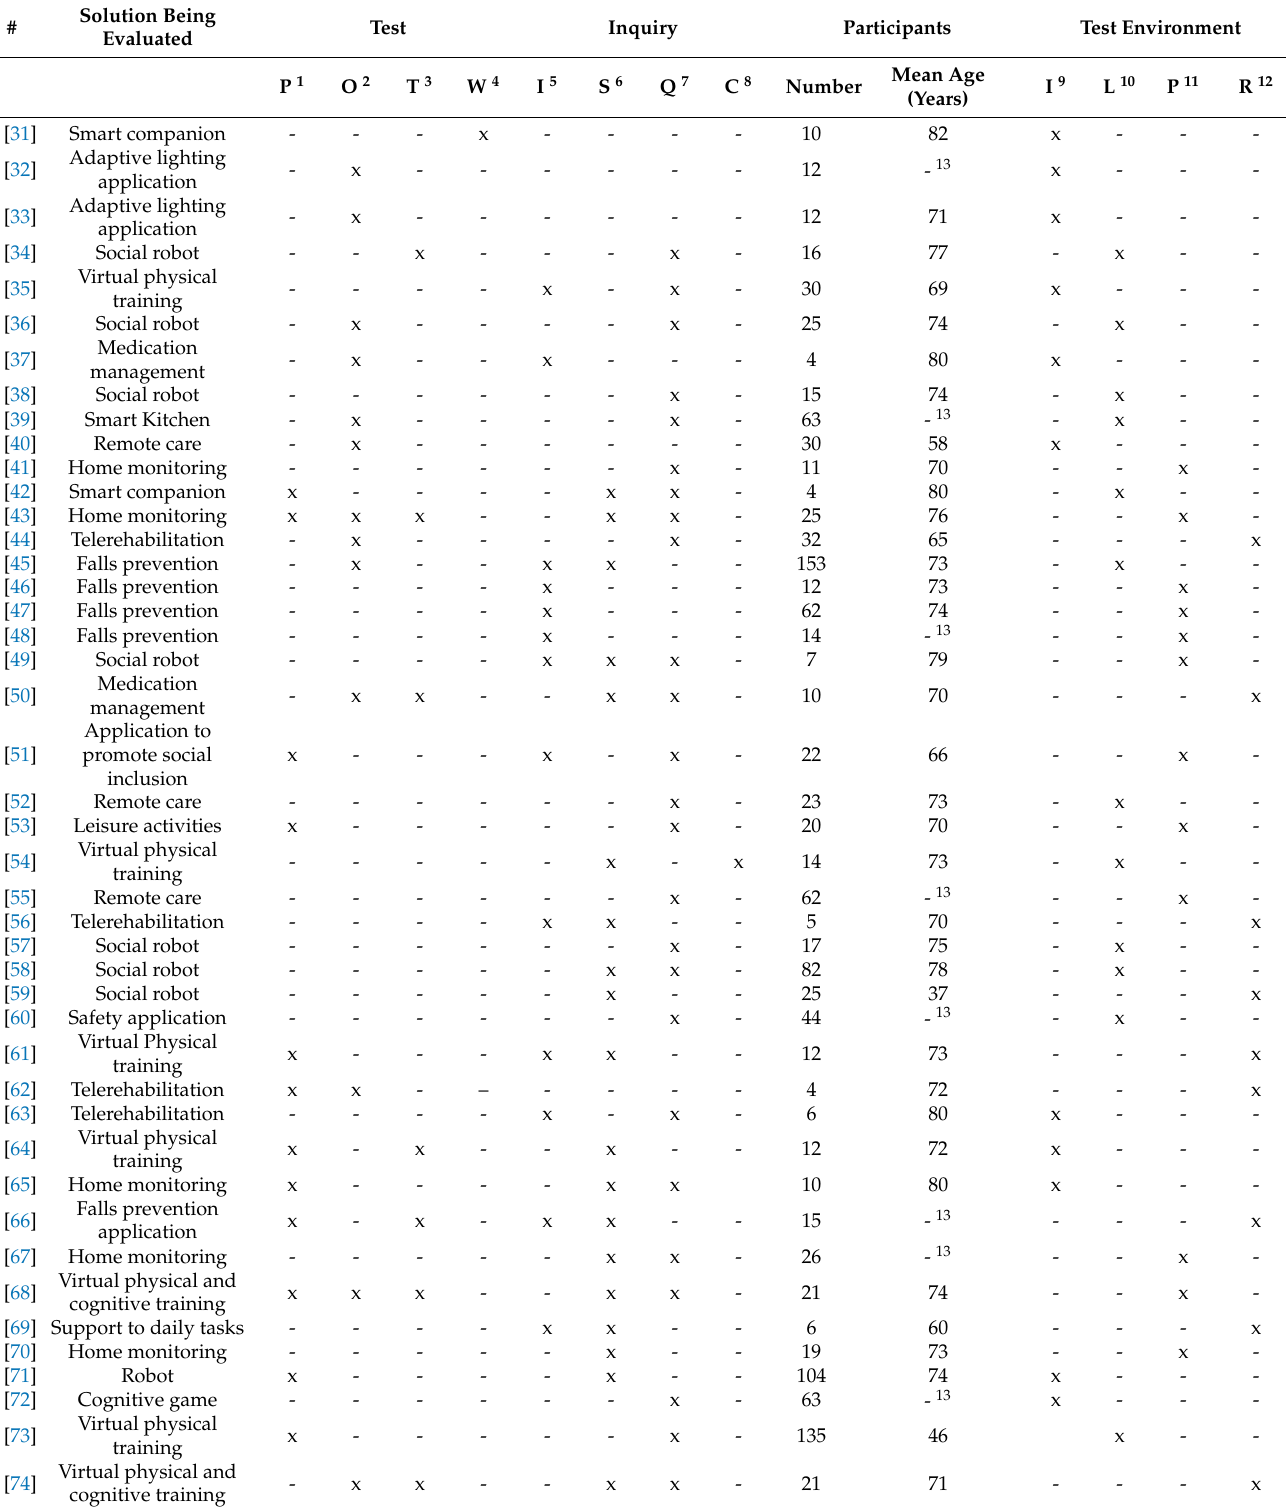
Table 5. Usability assessment